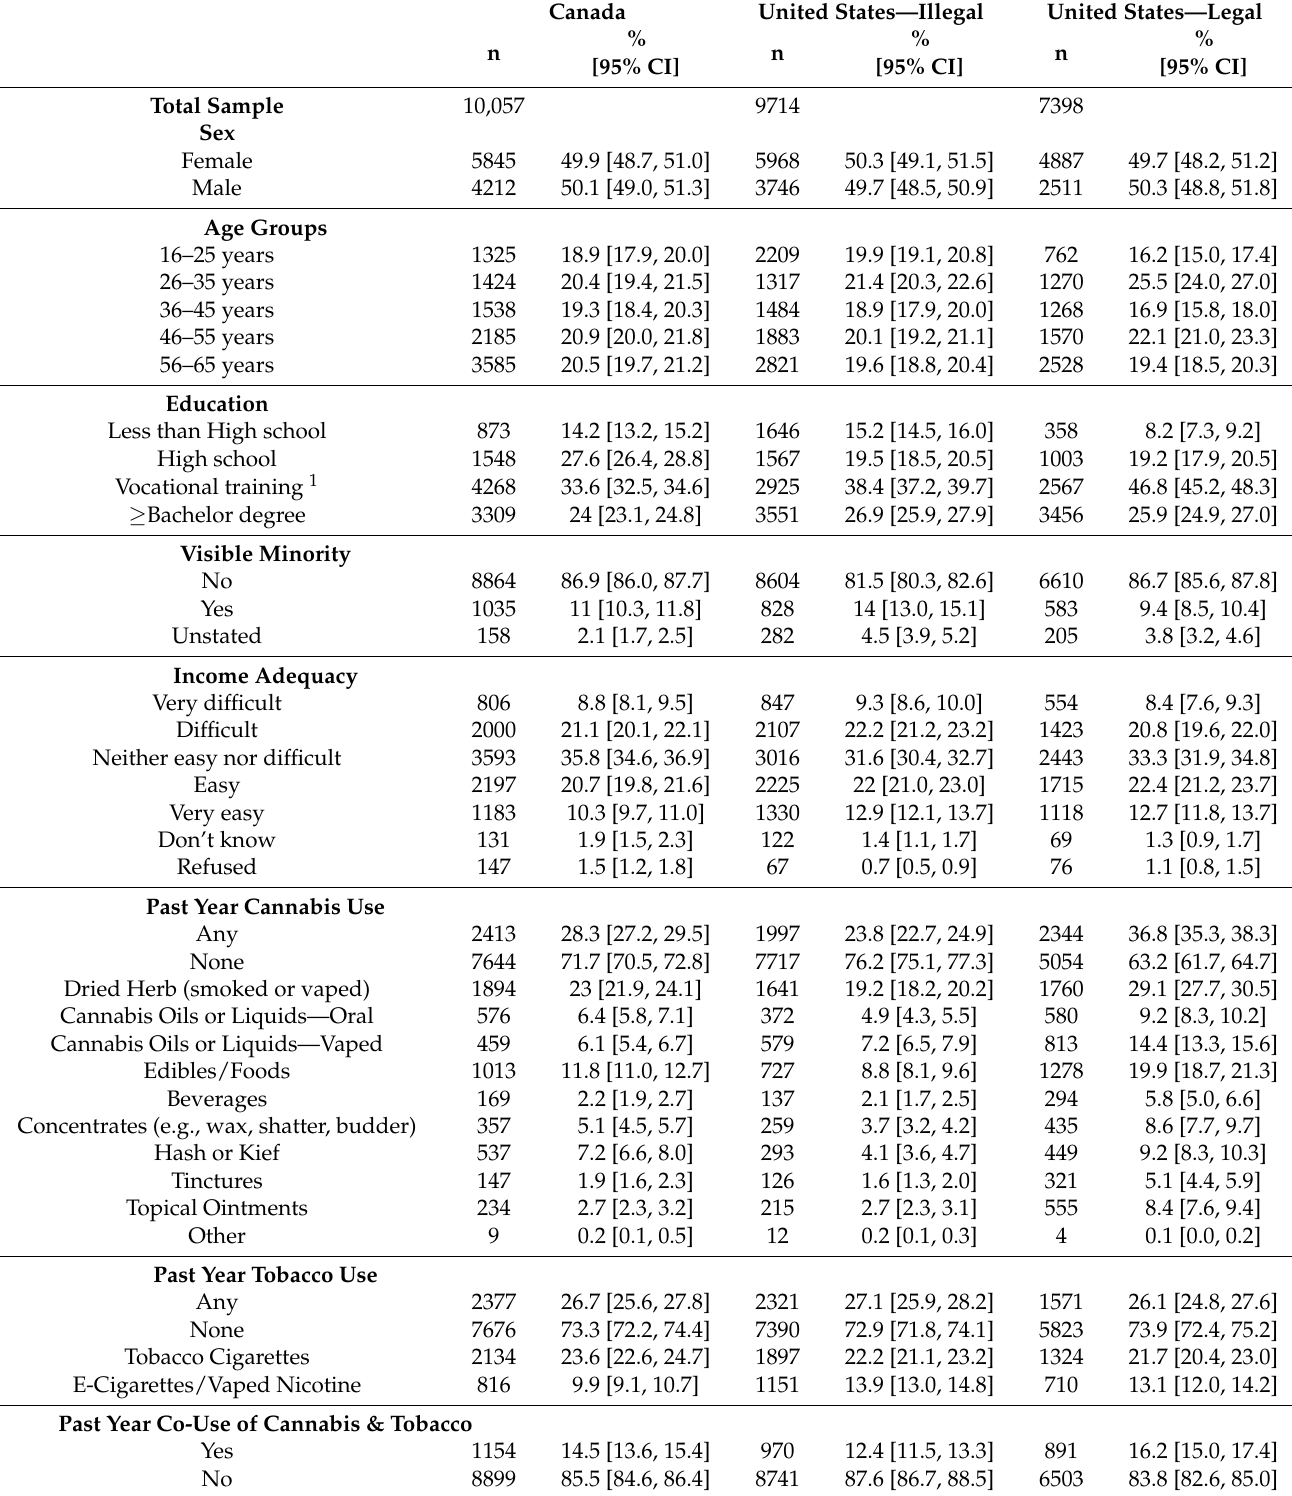
Table 1. Sample demographics and prevalence of co-use, simultaneous use, and